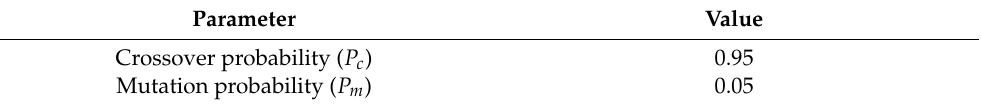
Table 3. Parameter setting of the non-dominated sorting genetic algorithm-III (NSGA-III) variant